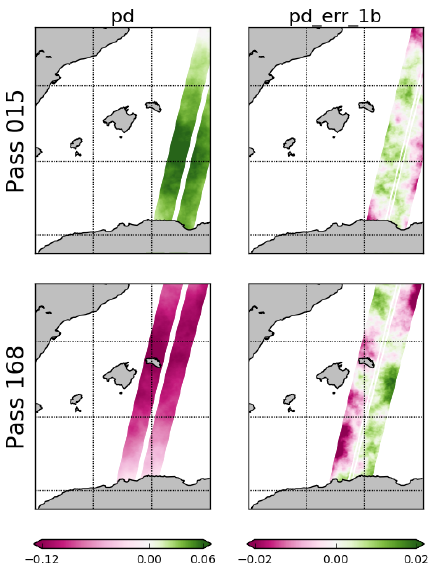
Figure A6. The different geophysical errors (m) for passes 15 and 168 over cycle 30 are shown. For more details on instrument and geophysical errors, see